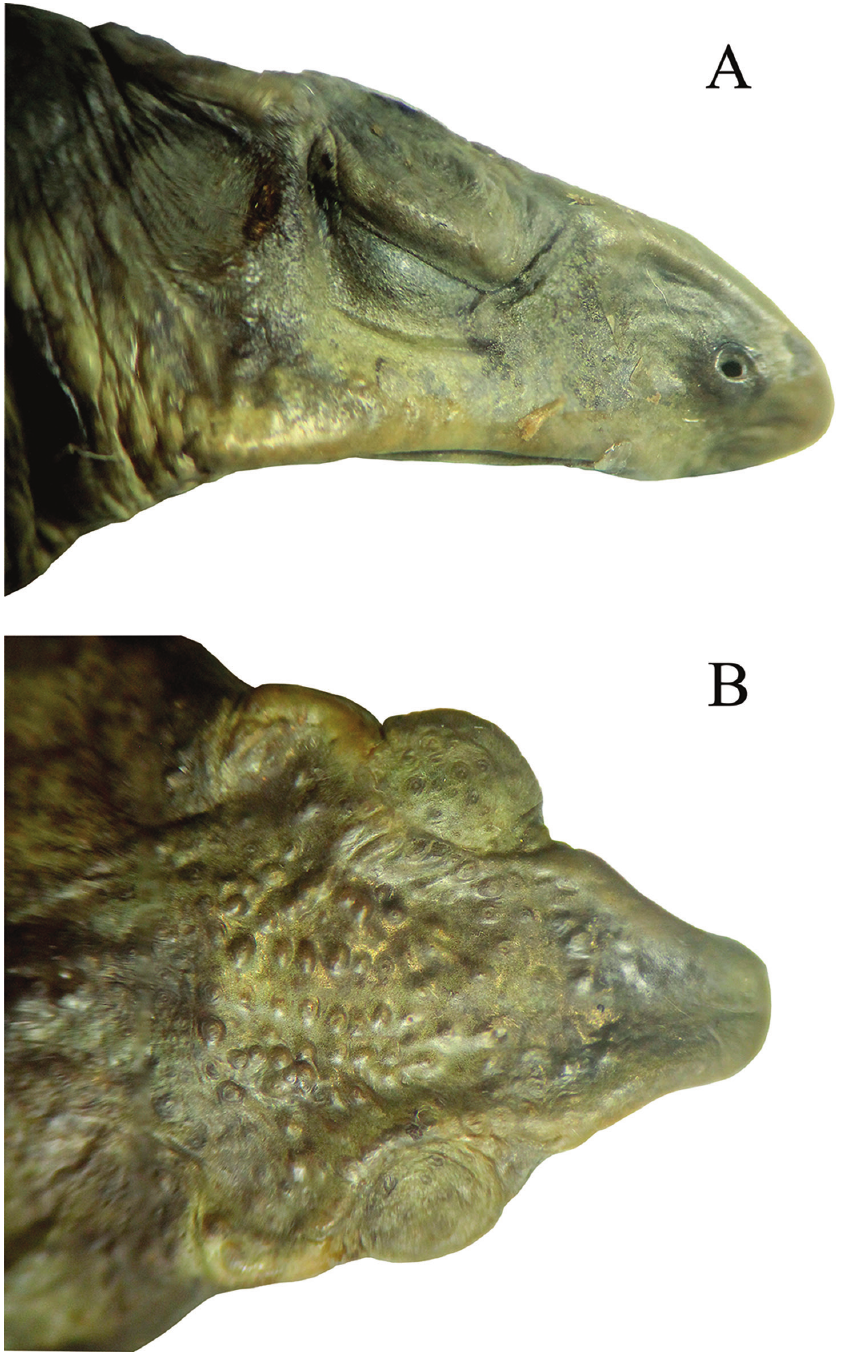
Figure 3. Holotype of Rhinella lilyrodriguezae sp. n. (MUSM 32204, head length = 15.9 mm), A lateral, and B dorsal views of head. Photos by J. C.